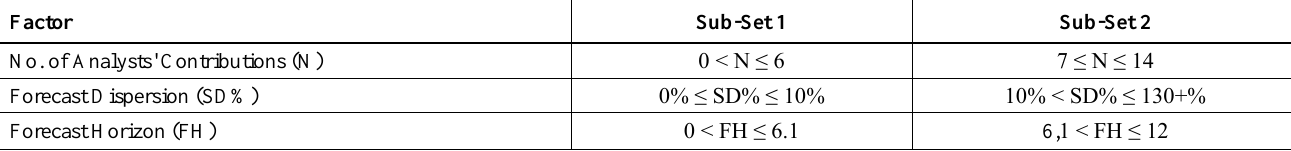
Table 1: Selected factor sub-set ranges Factor Sub-Set 1 Sub-Set 2 No. of Analysts' Contributions